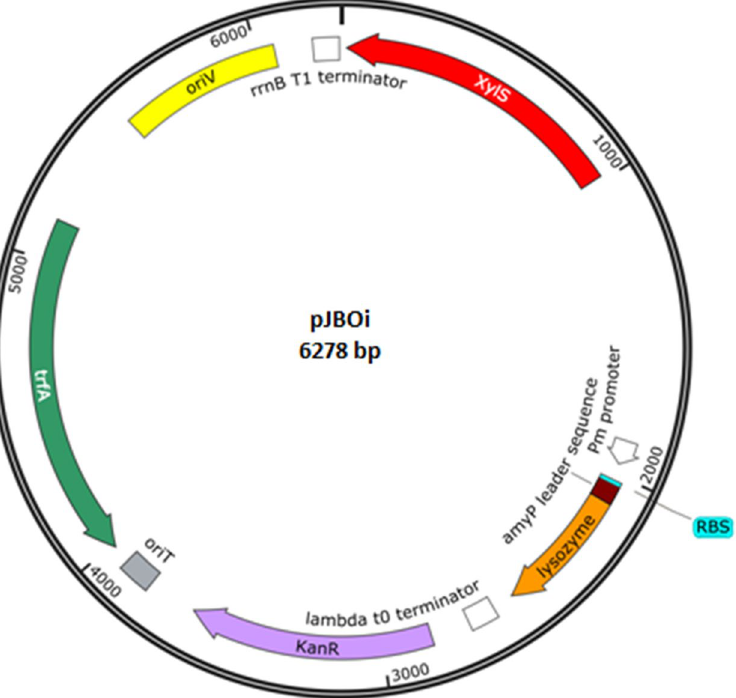
Figure 2. Illustration of the pSEVA228 expression plasmid employed in this study. The different specific features of this plasmid are outlined.